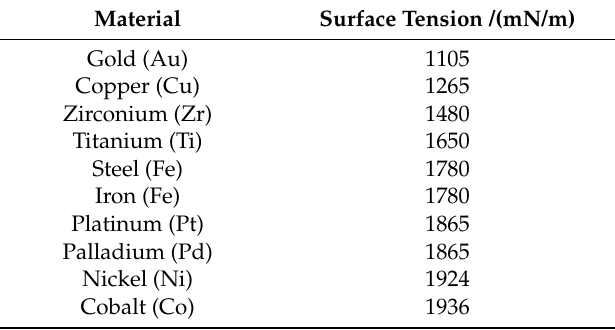
Table 1. Surface tensions of some